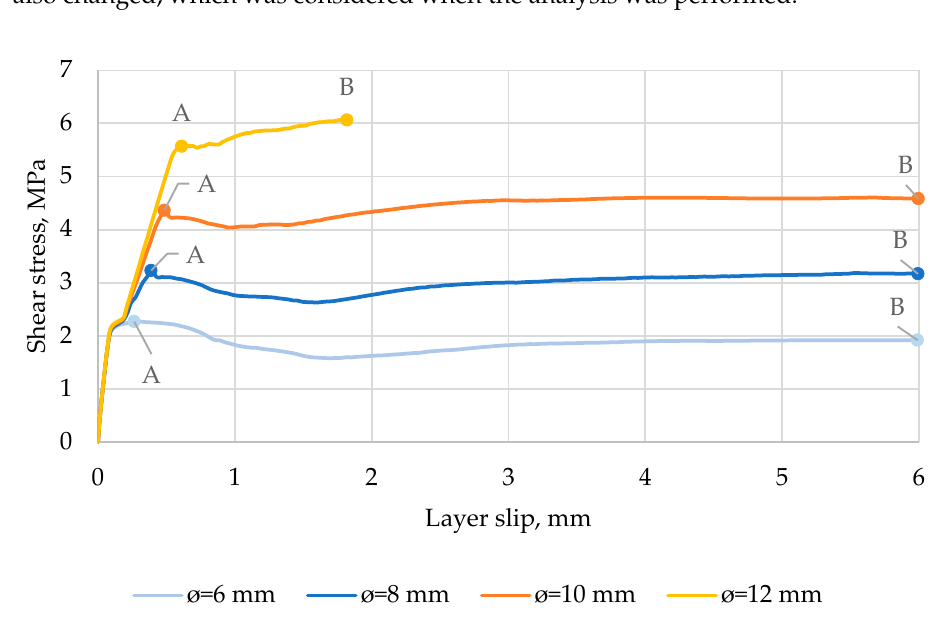
Figure 12. Shear stress–layer slip relationship depending on the connector bar diameter.